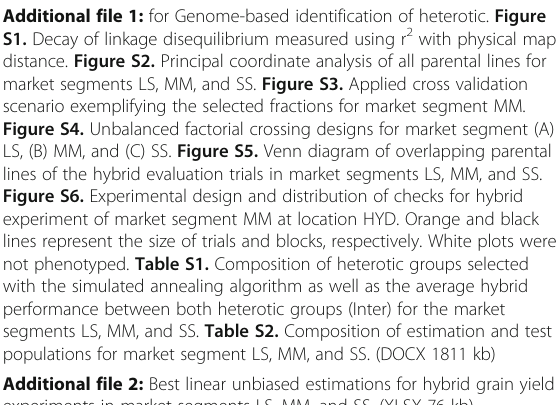
segments LS, MM, and SS. Table S2. Composition of estimation and test populations for market segment LS, MM, and SS. (DOCX 1811